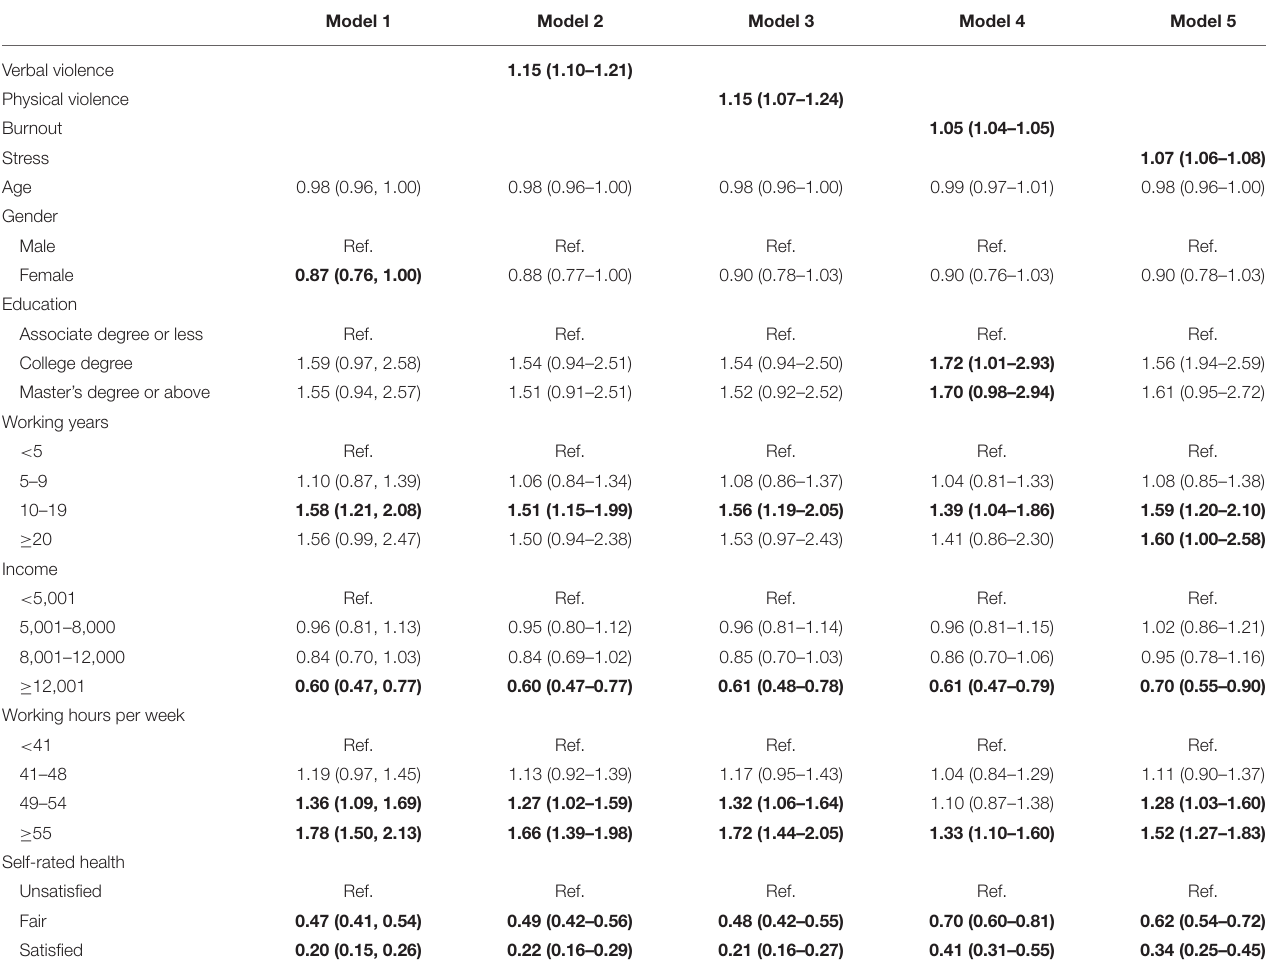
TABLE 3 | Logistics regression analyses for factors associated with turnover